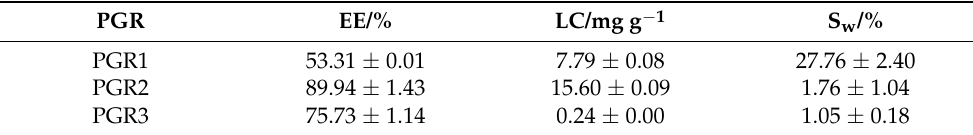
Encapsulation efficiency (EE), loading capacity (LC) and swelling degree (S w ) of CS/(ALG/(Ca+PGR)) microcapsule